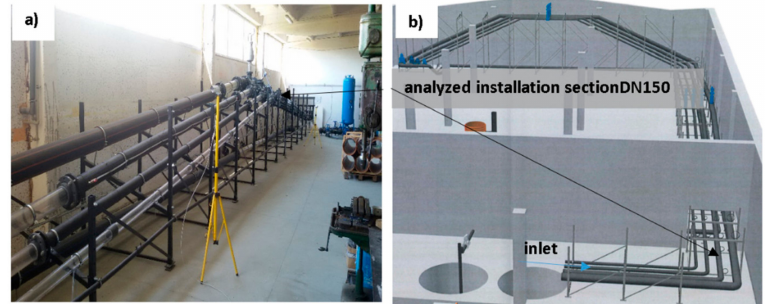
Figure 1. View of laboratory installation for testing processes in pressure sewerage pipelines; ( a ) general view (left), ( b ) diagram of the route and profile of the pressure pipeline with indication of the tested section with a siphon